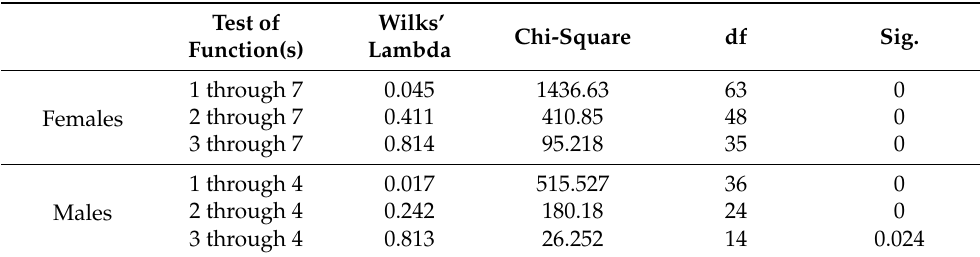
Table 4. Canonical discriminant analysis efficiency parameters to determine the significance of each canonical discriminant function.